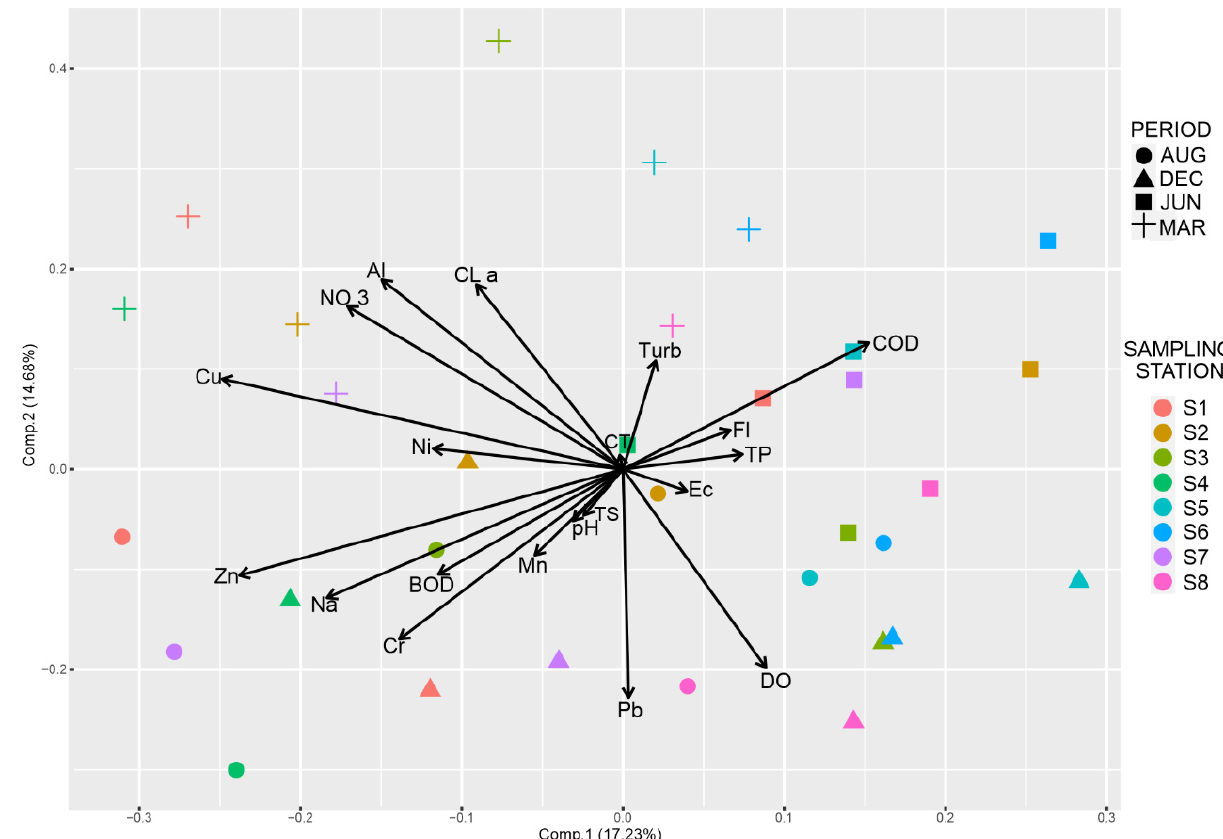
Figure 4. Principal Component Analysis (PCA) for the data evaluated at the sampling stations (S) of the Cascavel River, Cascavel city—PR, Brazil. Limnological data (Ec: electrical conductivity, DO: dissolved oxygen, Turb: turbidity, Fl: flow, COD: chemical oxidation demand, BOD: biochemical oxygen demand, NO 3 : nitrate, TP: total dissolved phosphorus, CL a : chlorophyll a, TS: total solids, CT: total coliforms), metals measured in the surface sediment (Cu: copper; Al: aluminum; Ni: nickel; Zn: zinc; Na: sodium; Mn: manganese; Pb: lead; Cr: chrome).